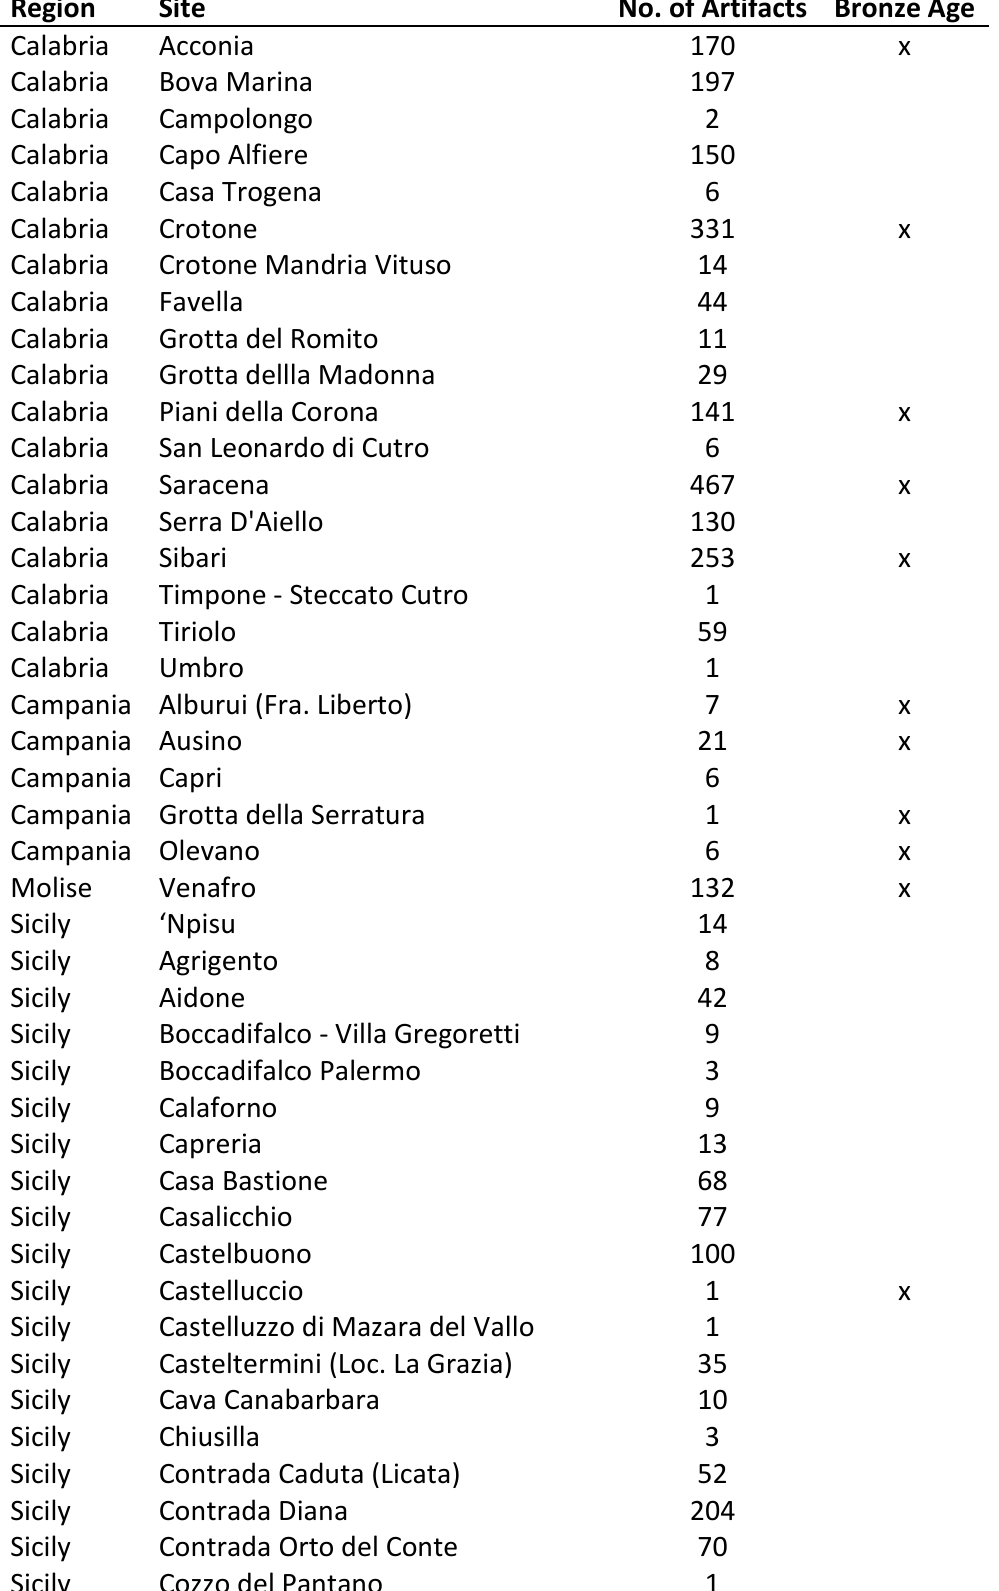
Table 1: List of artifacts analyzed with pXRF by authors, organized by site. Sites with at least some Bronze Age artifacts are indicated. All artifacts listed here were analyzed, with high numbers particularly from contexts in eastern Sicily and Ammerman’s surveys of